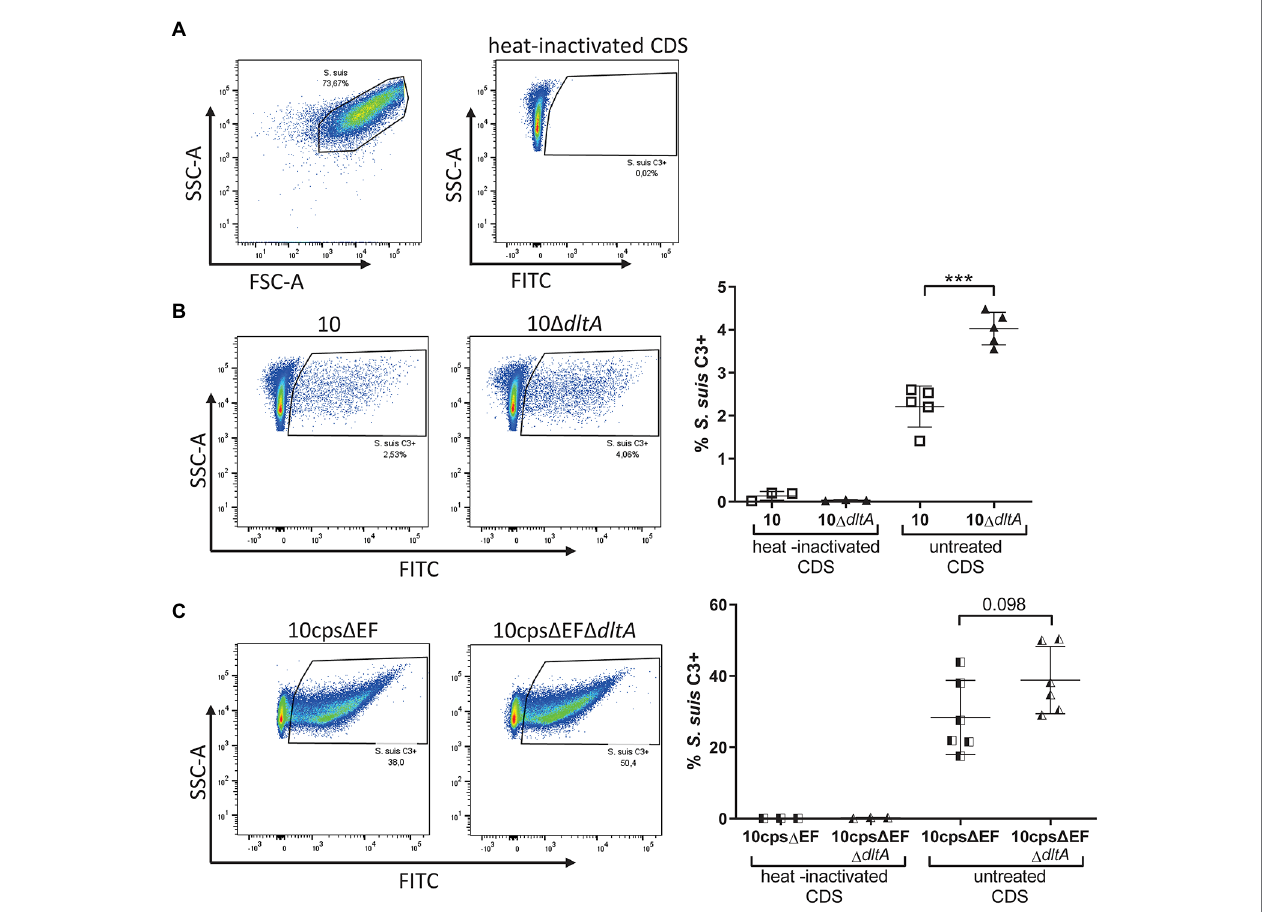
FIGURE 5 | Labeling with complement factor C3 is increased in Streptococcus suis 10 Δ dltA after incubation in active CDS. Streptococcus suis strains were grown to early exponential phase (OD 600 of 0.5) in THB and incubated with CDS for 1 h, followed by staining of C3 with a cross-reactive FITCs conjugated anti- human C3c antibody and measurement of C3 associated with the bacterial surface by flow cytometry. (A) Represents the gating strategy and negative control sample, while ( B ; encapsulated S. suis ) and ( C ; unencapsulated S. suis ) visualize representative examples on the left and the complete data sets on the right. Horizontal lines and error bars represent mean values and SDs. For statistical analysis, unpaired t -test was used to compare parent strain and respective Δ dltA mutant. *** p <